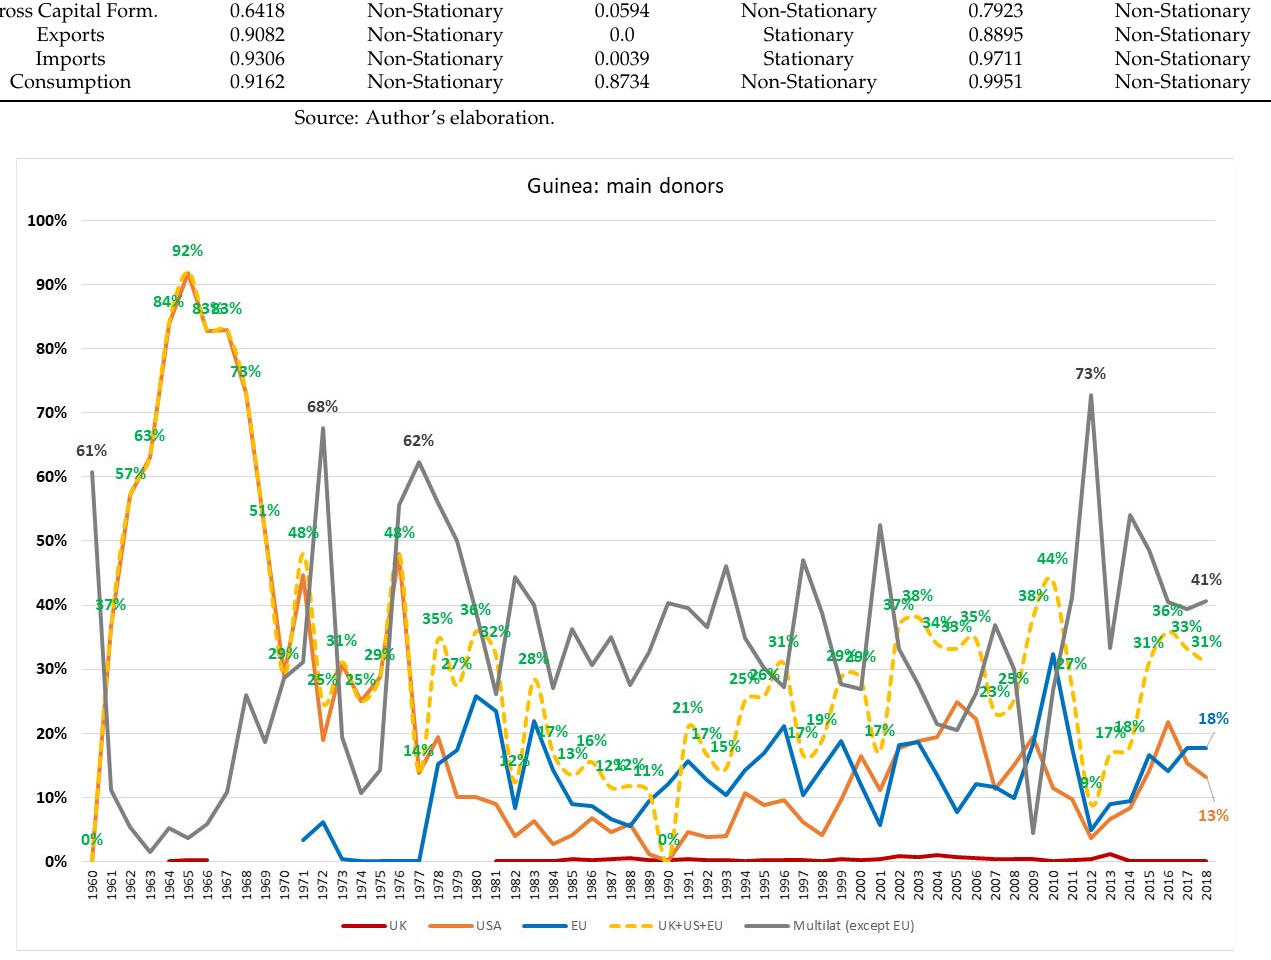
Figure 6. Main donors to Guinea. Source: Authors’ elaboration with data from OECD ‐ DAC Table 2a: net ODA total net disbursements in constant USD, 2018.